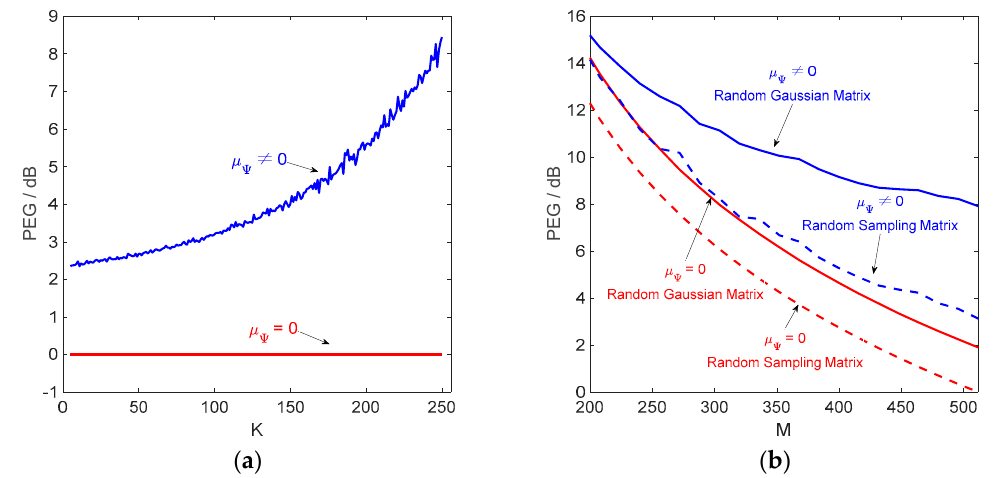
Figure 3. The projected energy gain (PEG) of wideband noise interference (WBNI) on a signal support set after sparse recovery. ( a ) Under different sparsity levels (M = N); ( b ) under different observation parameters (K = 100).